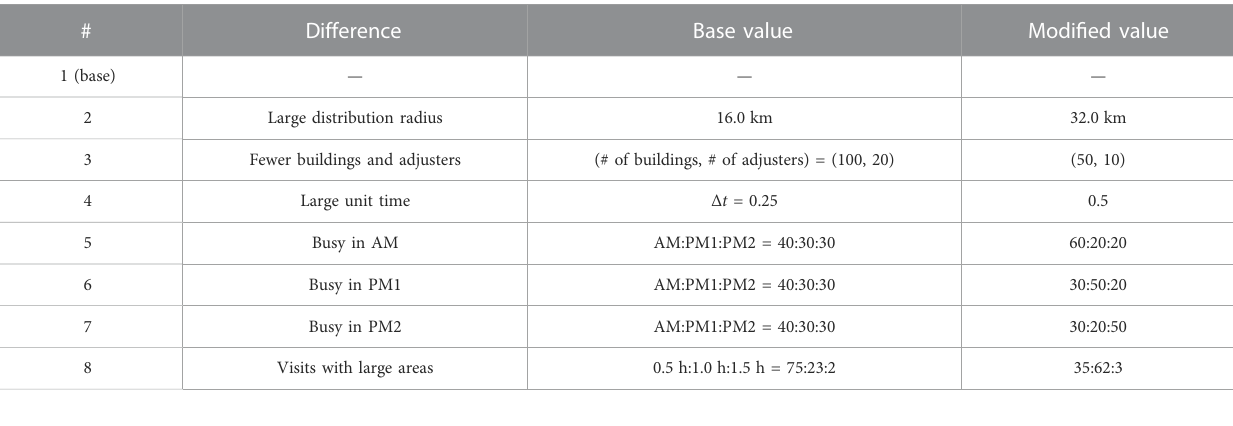
TABLE 8 Differences between the base case and other cases.